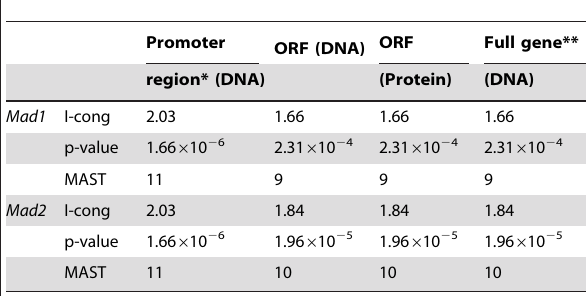
* , 800 base pair DNA sequence prior to open reading frame (ORF). **Promoter and open reading frame DNA sequences